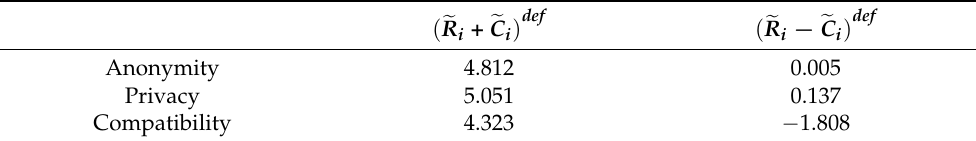
Table 9. Sum of ( (cid:101) R i + (cid:101) C i )